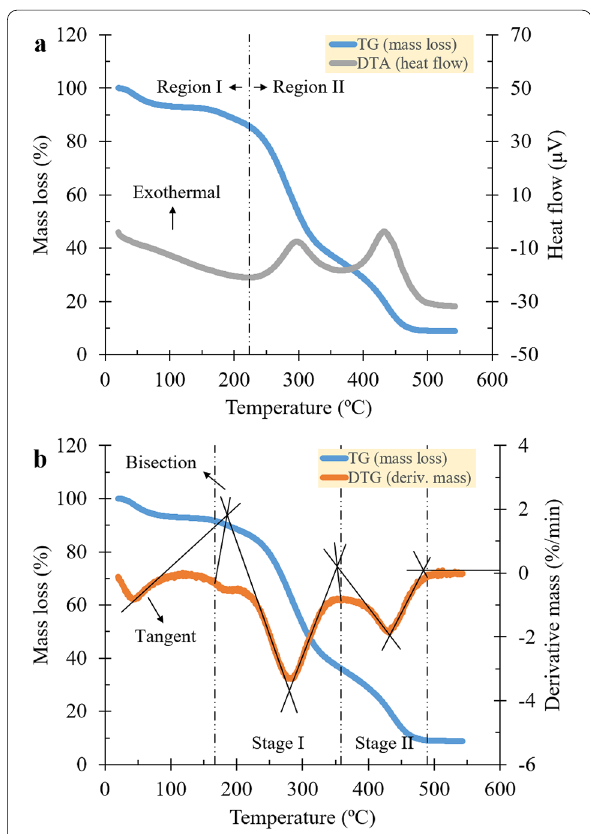
Fig. 1 Schematic for determining a the combustion reaction region and b combustion reaction stages (e.g., at a heating rate of 5 ºC/min;